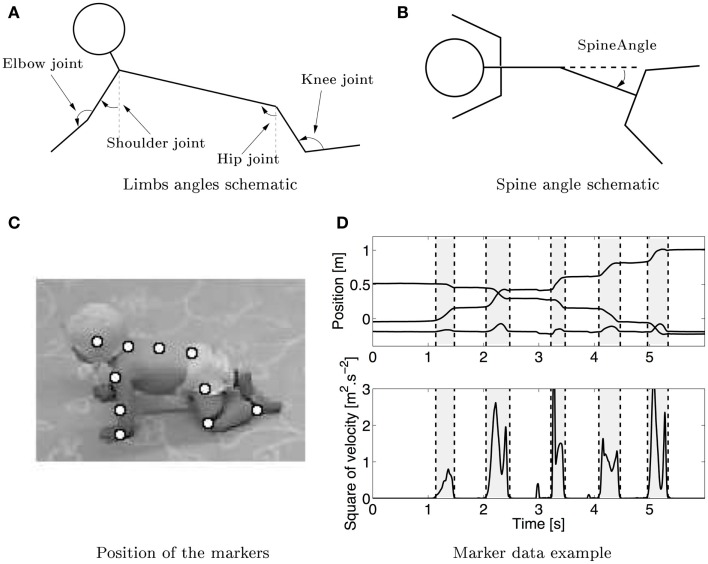
(A) Schematic (not based on real data) of the measured joint angles in sagittal plane. The shoulder, elbow, hip, and knee joints are measured. The arrows show the positive angles. The shoulder and hip joint were measured relative to the vertical. (B) Schematic of the spine angle made by the three markers on the spine measured in the lateral plane, the arrow shows the positive direction of the angle. (C) Snapshot of a crawling infant together with the position of the markers that were used to calculate the different angles. (D) Typical trajectory of the hand in x–y–z directions (upper graph, the lower line is the z direction, while the middle and upper one are respectively the y and x directions) during crawling with the corresponding squared velocity profile. Vertical dashed lines separate swing (gray) and stance (white) phases.